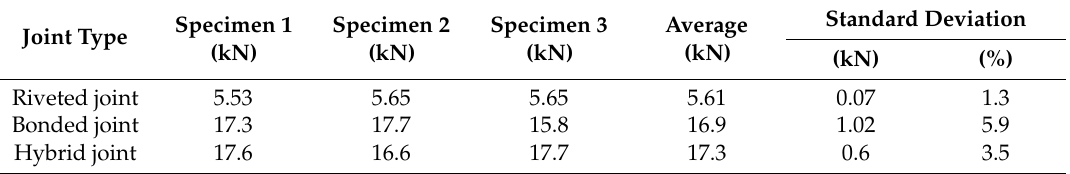
Table 6. Experimental results for strength of riveted, adhesive bonded, and hybrid joints with composite substrate and metal